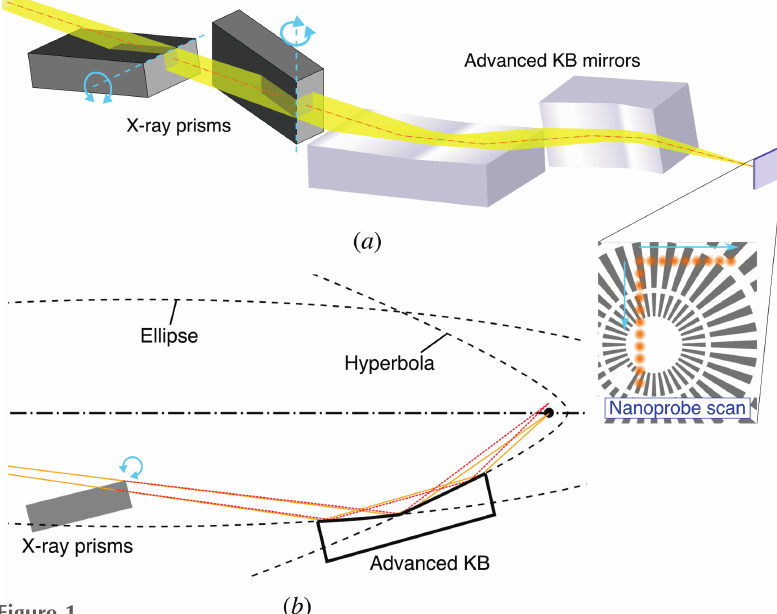
Figure 1 A conceptual schematic of the hard X-ray nanoprobe scanner. ( a ) A schematic of the hard X-ray nanoprobe scanner. ( b ) A cross section of the